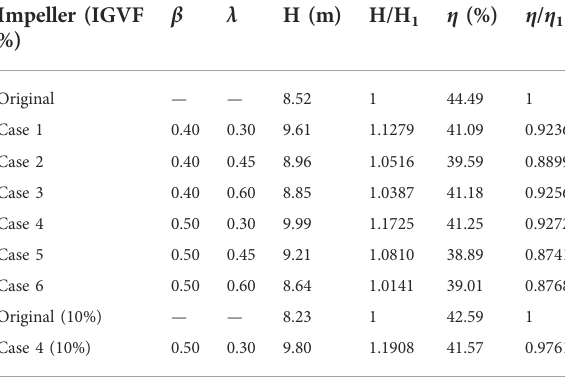
TABLE 3 External characteristics of the original and complex